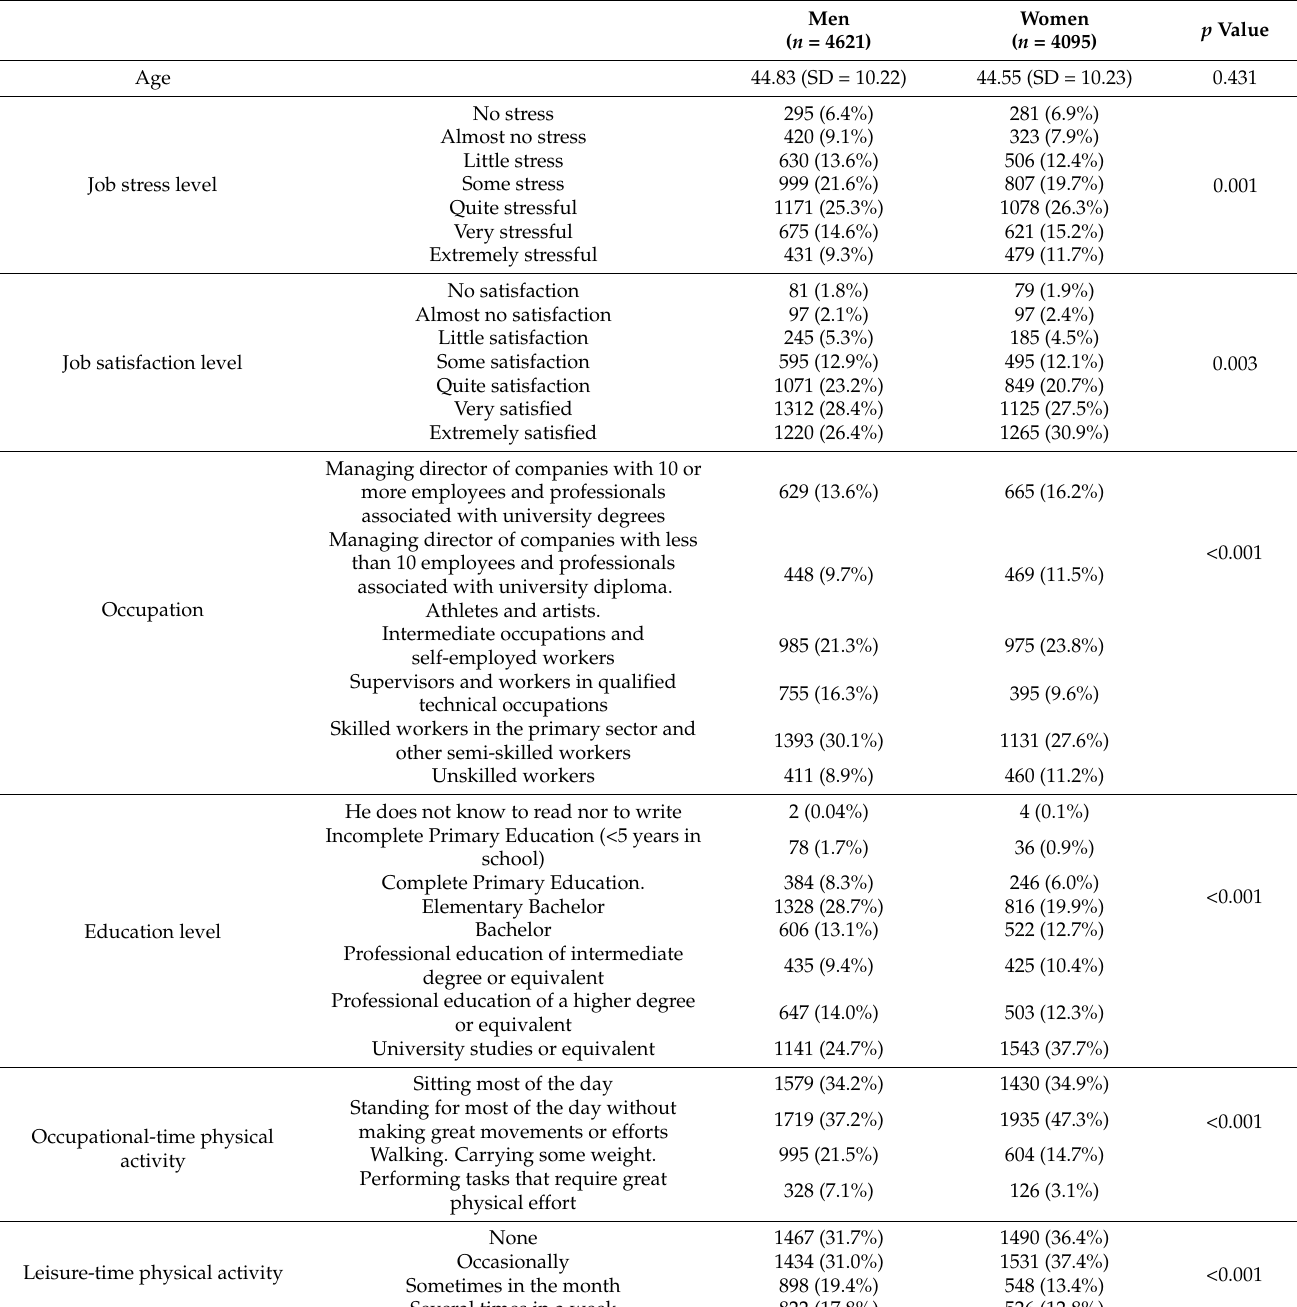
Table 1. Characteristics of the sample according to sex variable ( n =